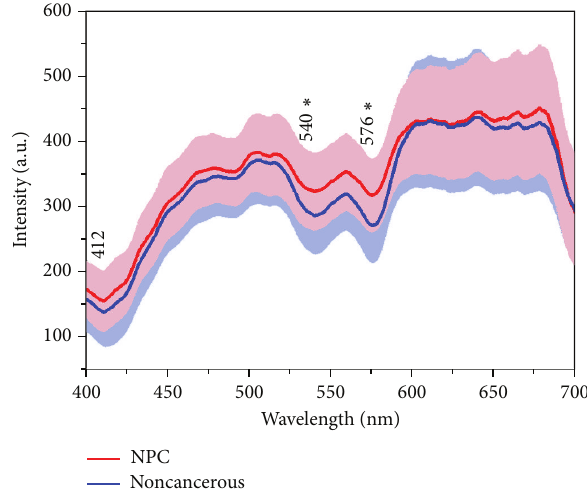
Figure 2: Mean reflectance spectra from NPC (red line, 𝑛 = 19 ) and noncancerous ex vivo tissue (blue line, 𝑛 = 18 ). Asterisks indicated significant difference ( 𝑝 value < 0.05) after 𝑡 -test, in which the 𝑝 values are 0.006 and 1.6 × 10 −4 for 540 nm and 576 nm, respectively. Areas (shaded) illustrate the respective standard deviations of the means